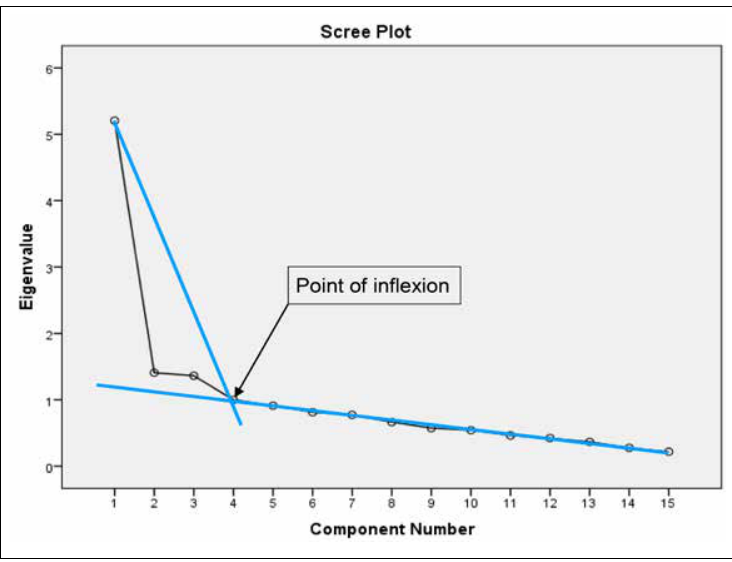
Figure 2: Scree plot for factors for BIM application barriers The scree plot confirms the finding of retaining three components. As a result, components from four up to fifteen are not significant and thus not included for analysis. Table 9 shows the three components that are meaningful to retain, where component 1 explains 34.695% of the total variance; component 2 explains 9.386%, and component three explains 9.088% of the